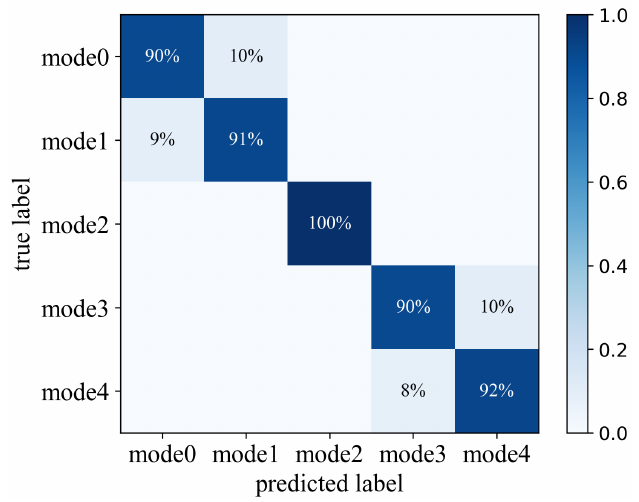
Figure 11. Confusion matrix of rate adaption over different